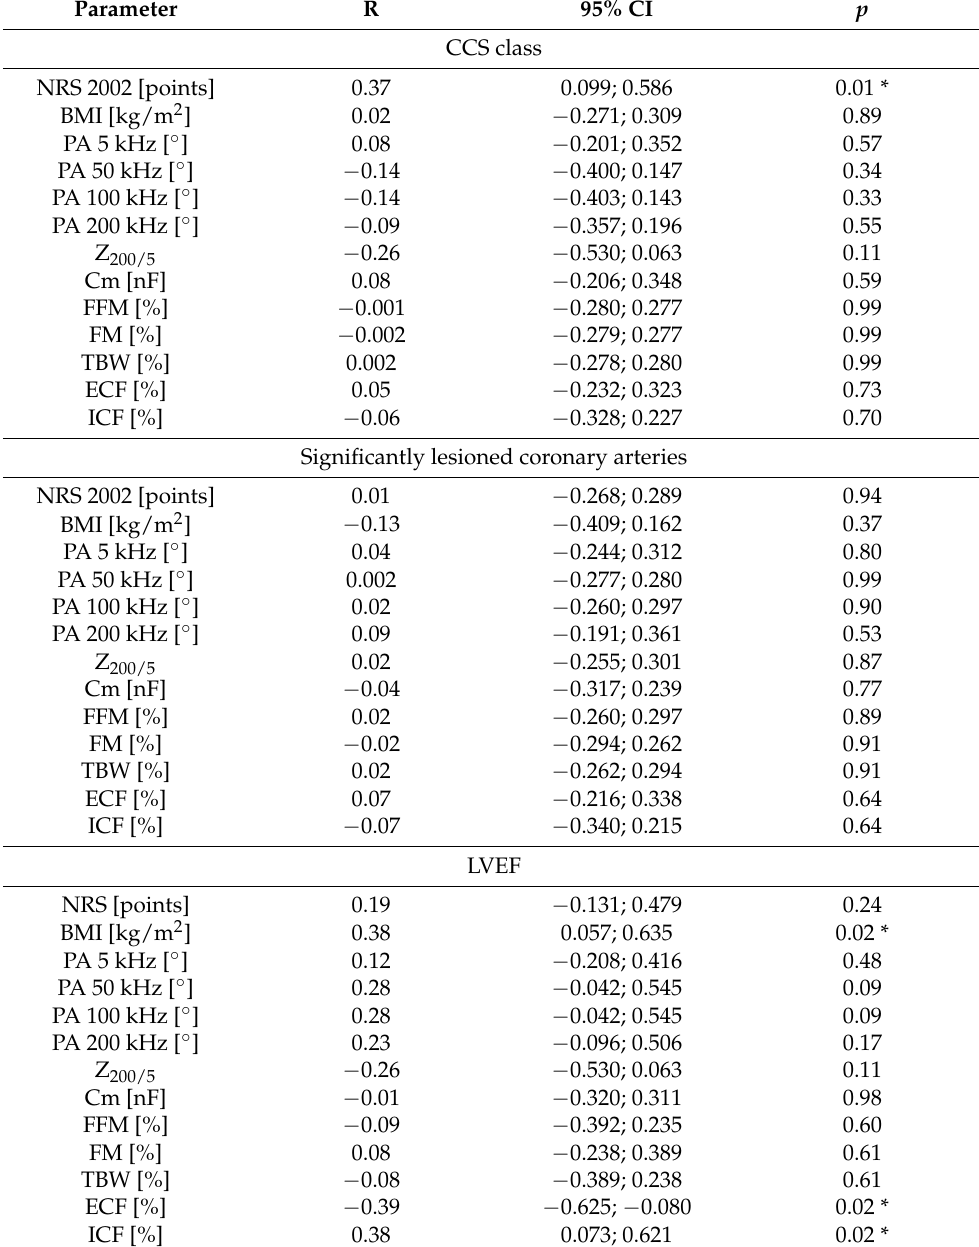
Table 3. Correlation between nutritional status and main CAD